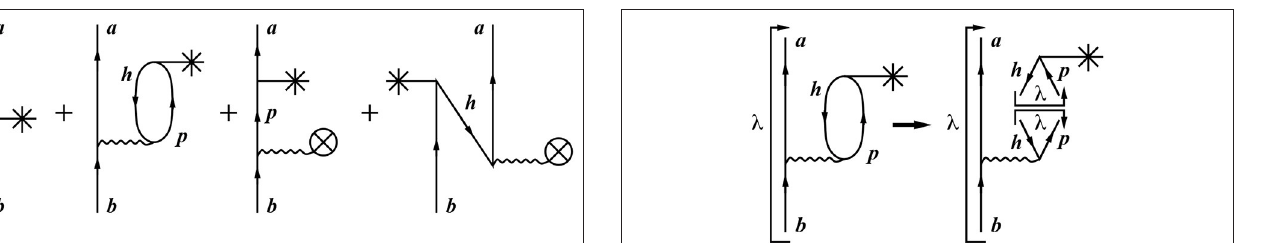
FIGURE 10 | One-body second-order diagrams included in the perturbative expansion of ˆ 2 0 ; an asterisk indicates the bare operator 2 . FIGURE 11 | One-body second-order 2 p -1 h diagram included in the perturbative expansion of ˆ 2 0 ; an asterisk indicates the bare operator 2 .